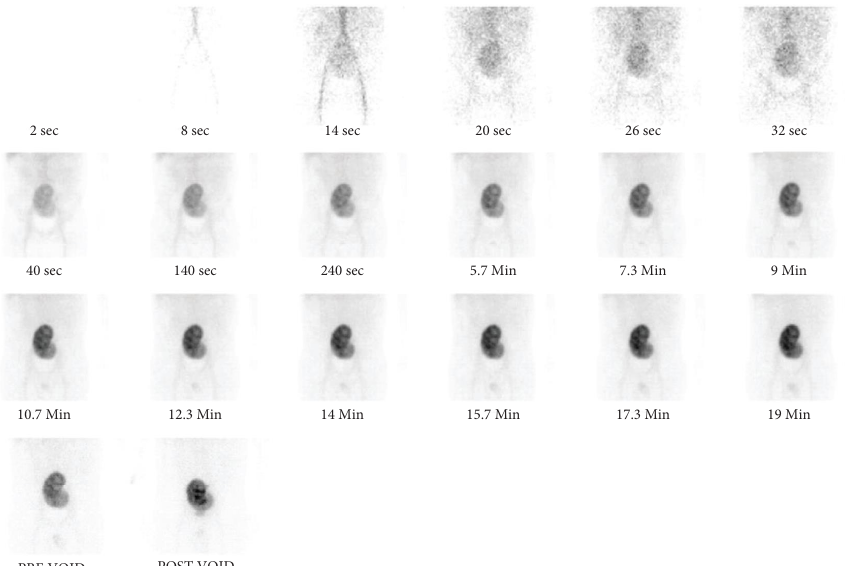
Figure 4: Kidney scintigraphy performed on day 158 post-transplant showing displacement of the transplant kidney to the midline, still with some perfusion present.